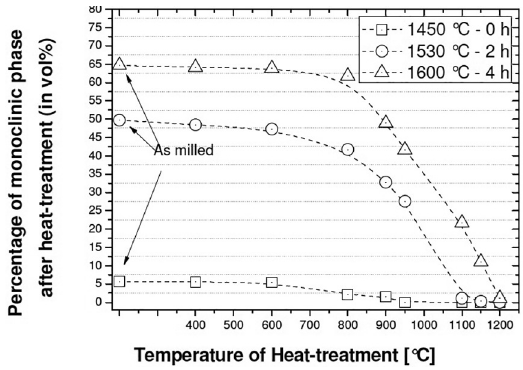
Figure 5. Amount of monoclinic phase formed after crushing the sintered samples (as milled) and after subsequent heat treatments. Because the depth of penetration of X-rays, estimated to be in the order of 4.5 µm, it is reasonable to assume that the materials with larger grain sizes, as the samples sintered at 1600 ºC - 4 h (1.31 µm grain size) are much more influenced by the transformation at the fracture surface than samples with smaller grain